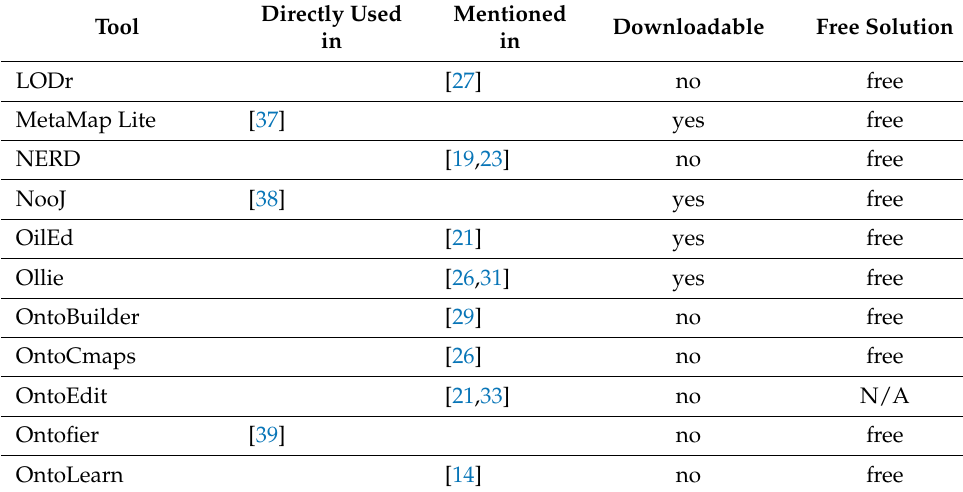
Downloadable Free Solution